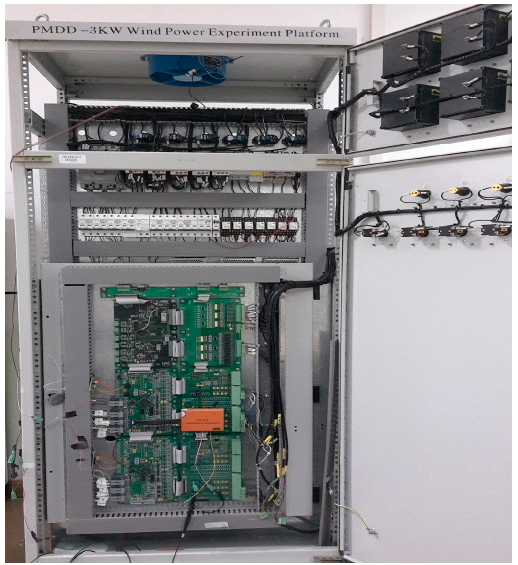
Figure 17. The experimental platform of stability analysis in inverter-grid system.